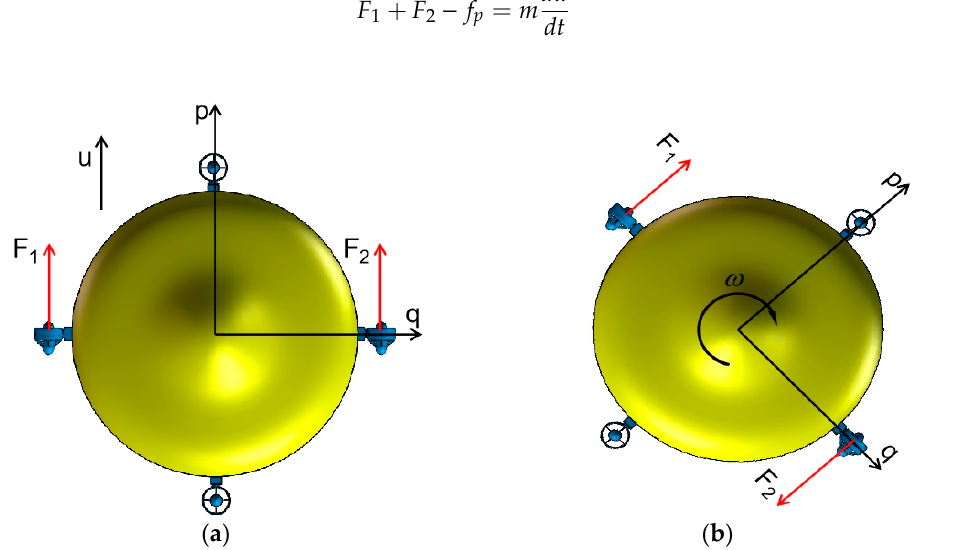
Figure 3. Force analysis of horizontal motion. ( a ) Linear motion; ( b ) rotation motion.